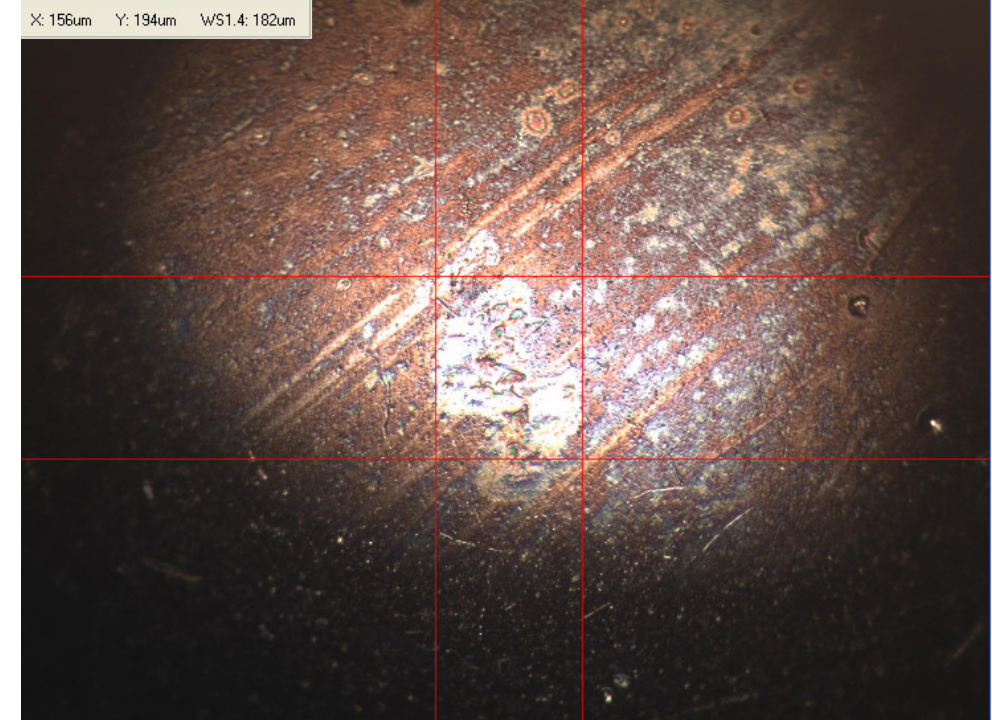
Figure A1. SAE 30–100%; DO—0%.